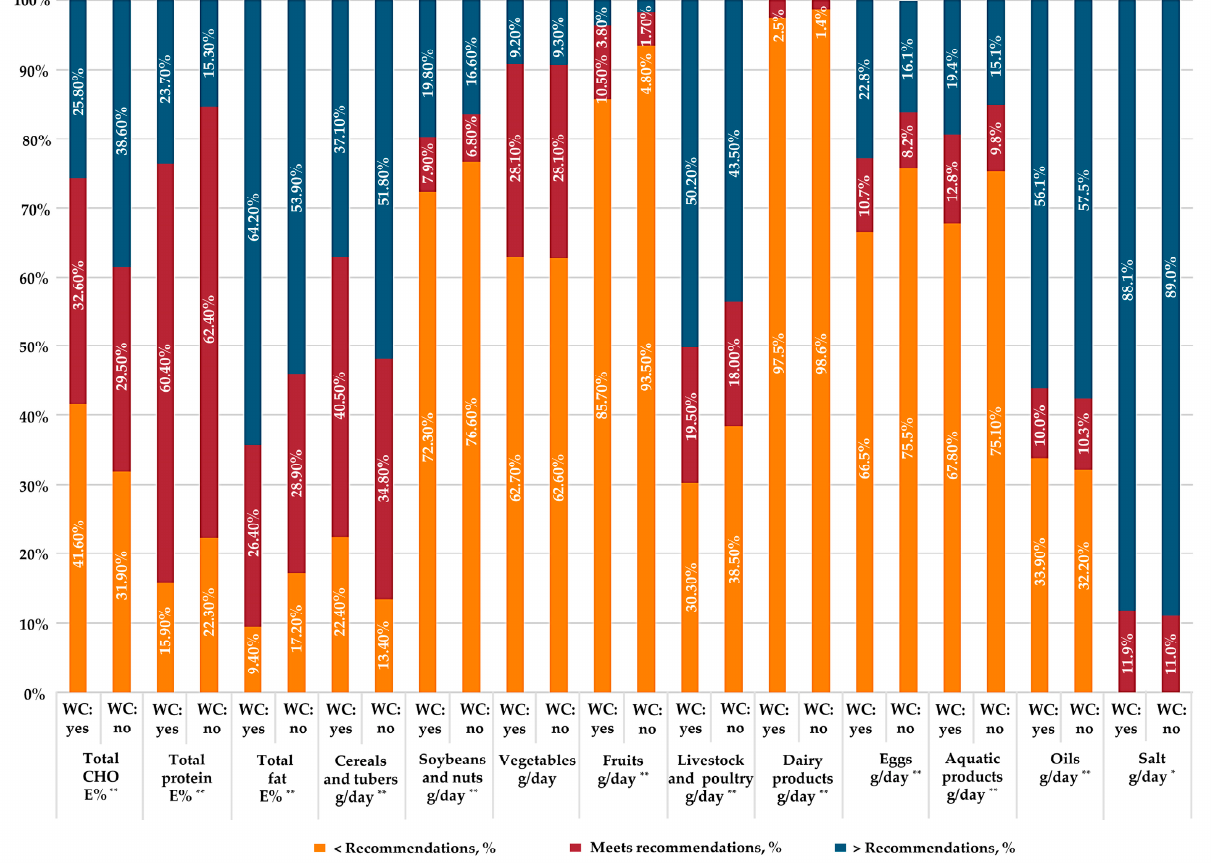
Figure 2. Percentage of Chinese adults complying with the dietary recommendations in the three rounds China National Nutrition Surveys. Dietary recommendations in the Dietary Guidelines for Chinese Residents (2016): 25–35 g/day soybeans and nuts; 250–400 g/day cereals and tu- bers; 300–500 g/day vegetables; 40–75 g/day livestock and poultry meats; 200–350 g/day fruits; 40–50 g/day eggs; 40–75 g/day aquatic products; >300 g/day dairy products; 25–30 g/day oil; <6 g/day salt. Dietary recommendations in the Chinese dietary reference intakes: 50–65 E% CHO, 10–15 E% protein, and 20–30 E% fat. Comparison of complying with the dietary recommendations between adults with and without weight-control behavior was conducted using the chi-square